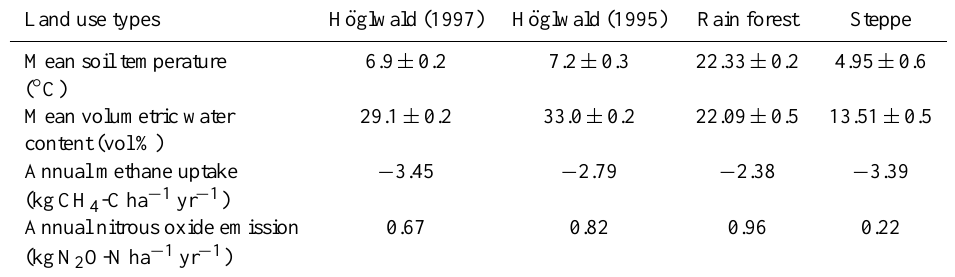
Table 2. Flux rates of nitrous oxide and methane from soils of each land use type as observed for all temperature and moisture conditions. Annual cumulative values are summed after linear interpolation. All parameters are significantly ( p < 0.05) different between